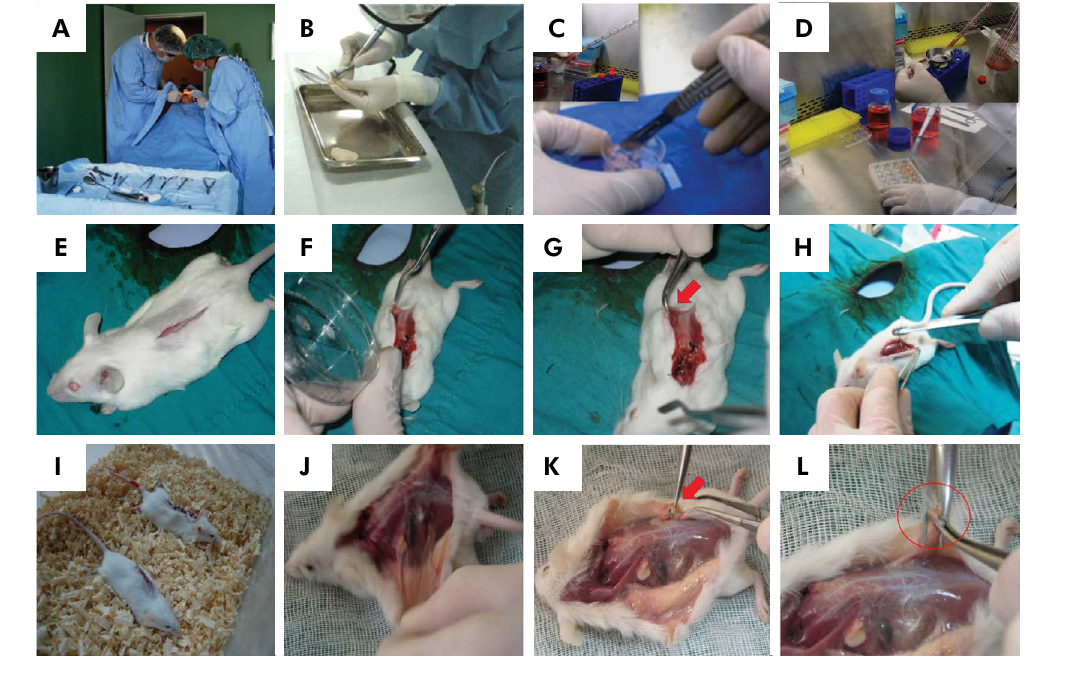
Figure 1. Stages of the method. (A) Tooth extraction. (B) Pulp tissue isolation. (C) and (D) Cell isolation and culture. (E-I) Transplantation. (J-L) Tissue formation after